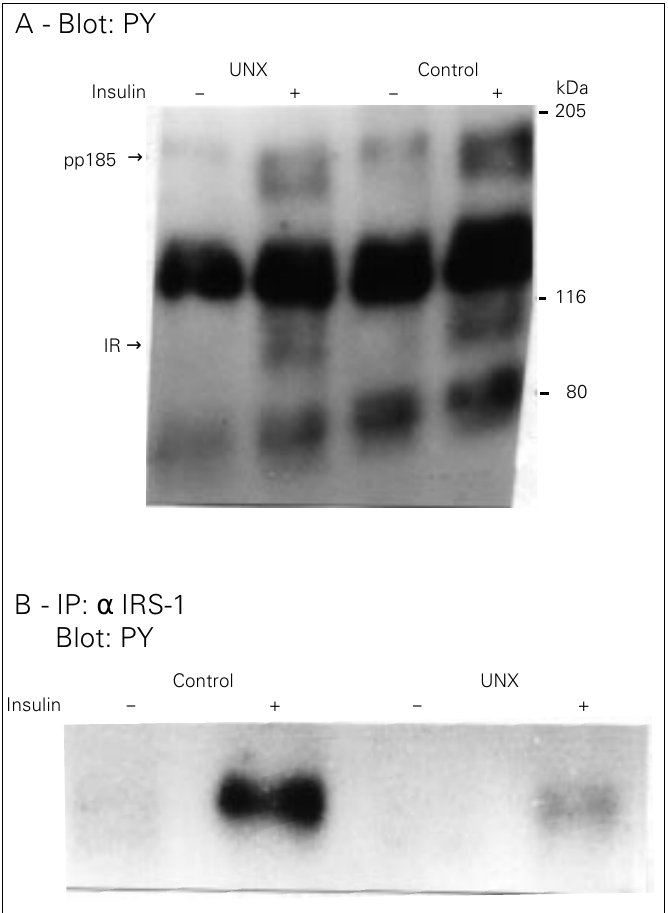
Figure 1 - A , Insulin receptor (IR) and pp185 tyrosine phosphorylation in remnant kidney tissue after saline (-) or saline plus 10 µM insulin (+) in unilaterally nephrectomized (UNX) rats, compared with controls. The tissue was extracted as described in Methods and immunoblotting (Blot) of total tissue extracts was performed with anti-phosphotyrosine antibody (PY) and 125 I-Protein A. B , Effect of unilateral nephrectomy on insulin receptor substrate 1 (IRS-1) in the rat remnant kidney. Kidney extracts from controls and unilaterally nephrectomized rats were immunoprecipitated (IP) with anti-IRS-1 antibody ( a IRS-1) and then immunoblotted with anti-phosphotyrosine